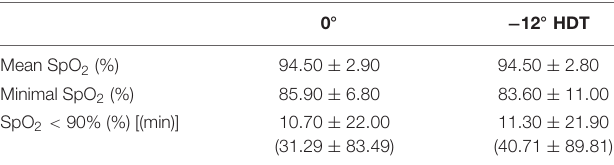
no significant change in minimum oxygenation detectable ( − 12 ◦ :